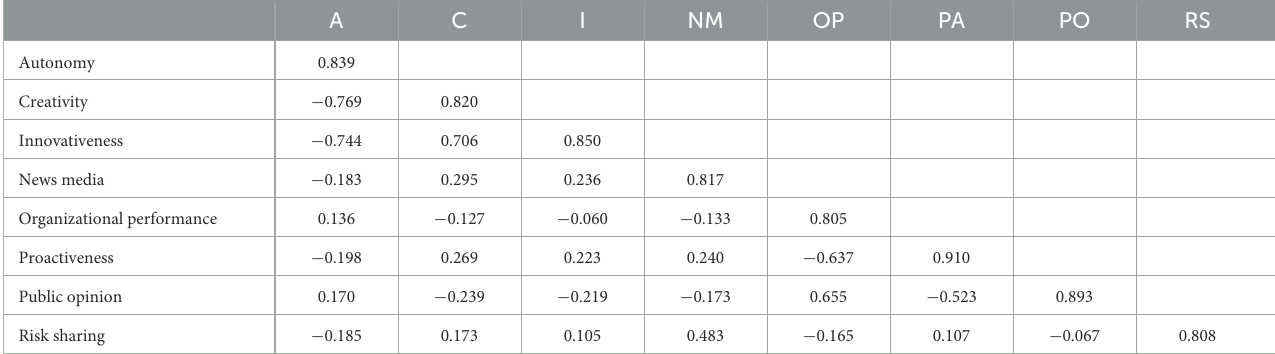
TABLE 5 Discriminant validity (Fornell-Larcker).